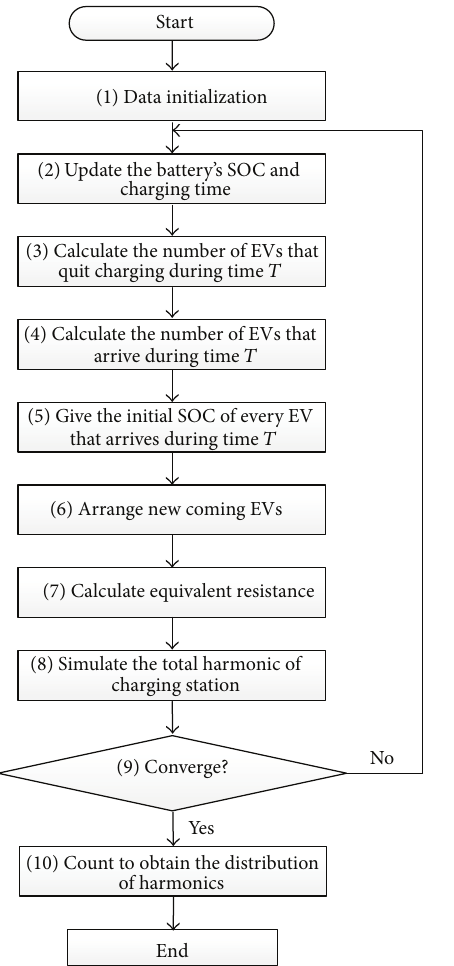
Figure 6: Calculating the EV charging station’s harmonic distribu-